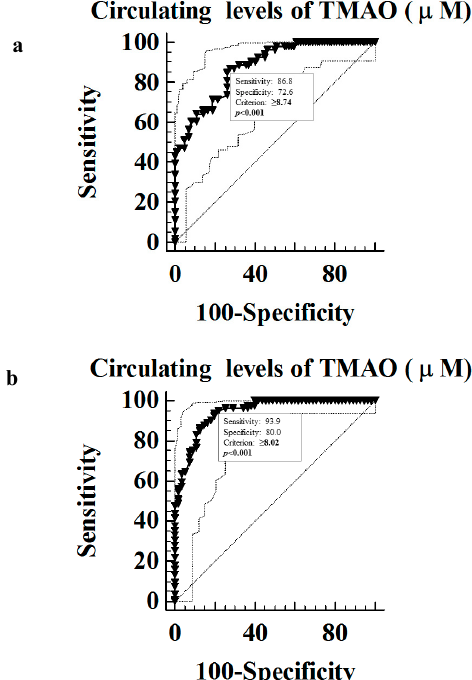
Figure 2. ROC for predictive values of circulating levels of TMAO in detecting FLI ( a ) and MetS ( b ). A p -value in bold type denotes a significant difference ( p < 0.05).